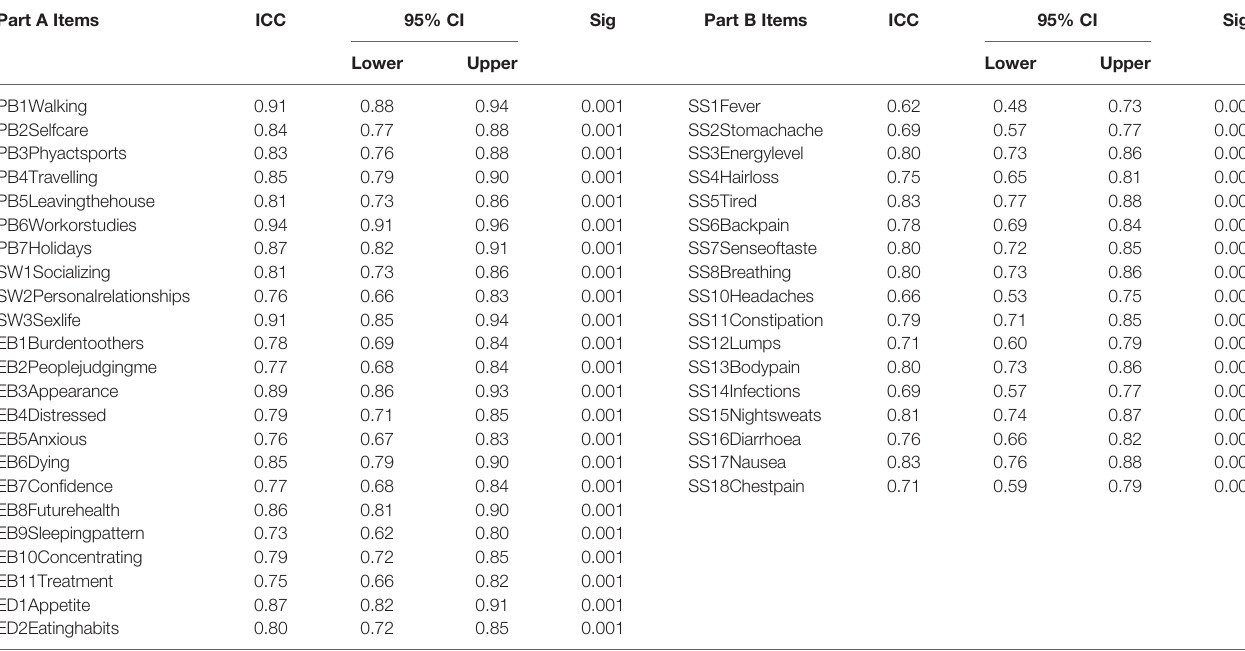
TABLE 3 | Intra-class Correlation Coef fi cient (ICC) for individual items of Part A and Part B of the HM-PRO (n = 150). Part A